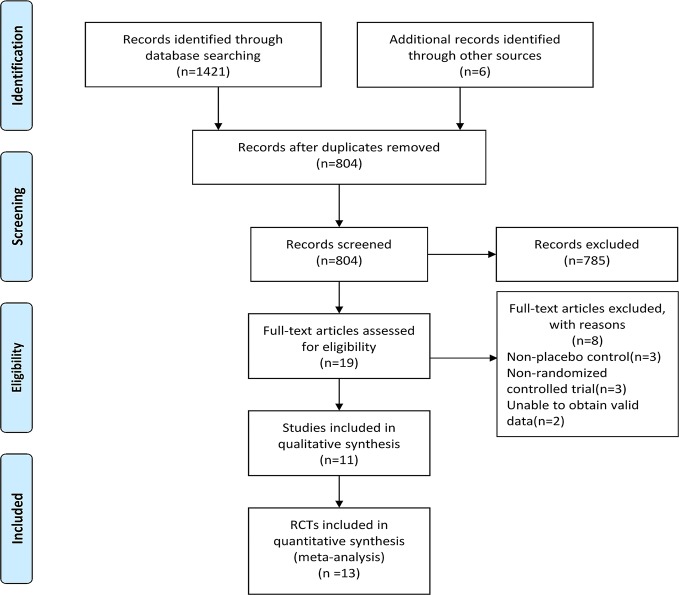
PRISMA flow diagram.